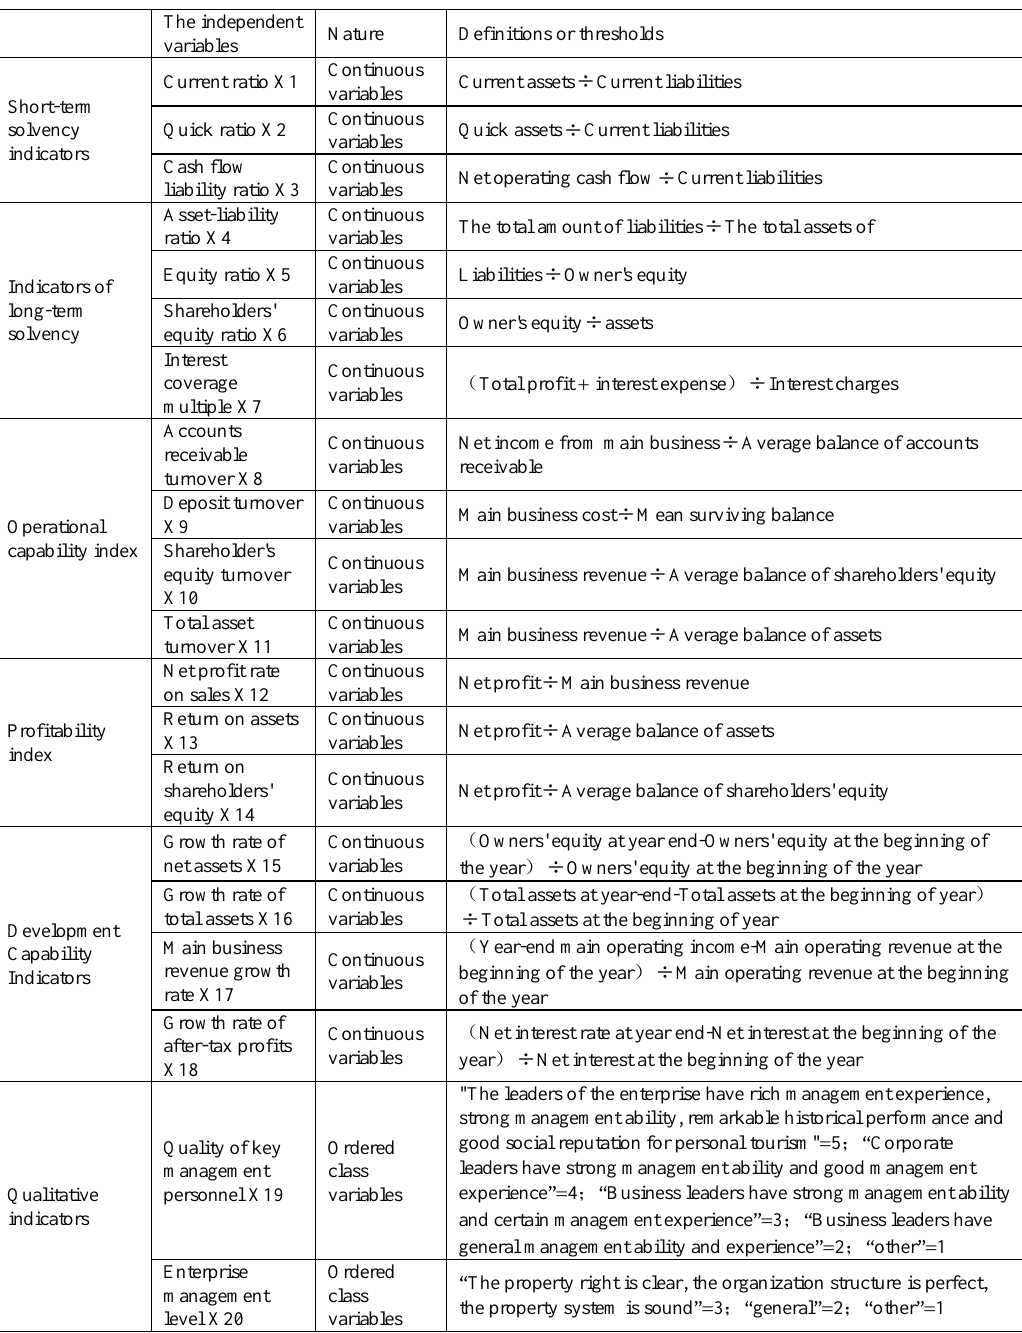
Table 1 Properties of independent